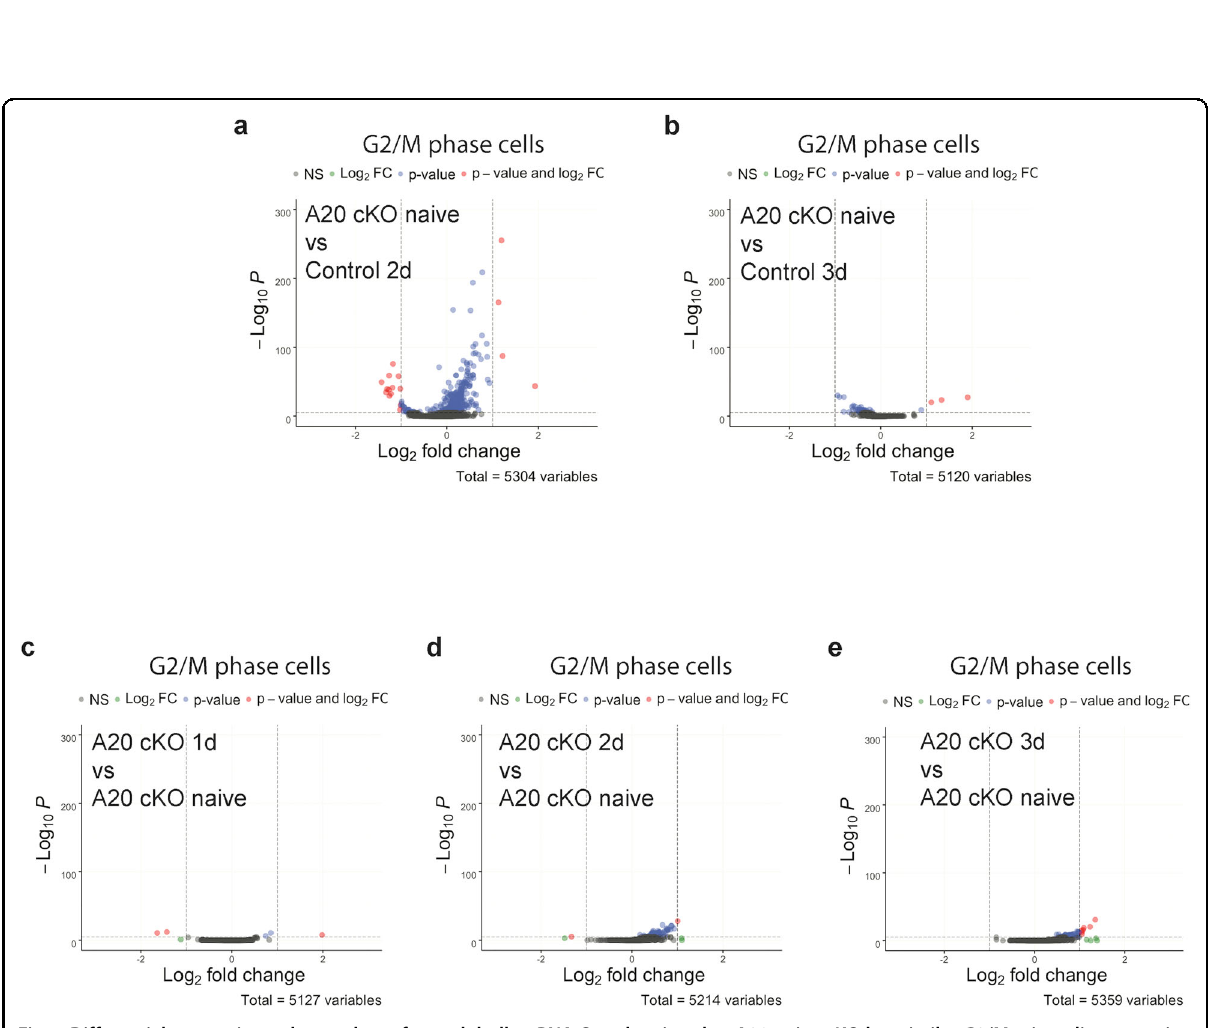
Fig. 4 Differential expression volcano plots of pseudobulk scRNA-Seq showing that A20 naive cKO has similar G2/M microglia expression pro fi le as control 3 days after nerve injury. a The G2/M-phase microglia of naive uninjured Cx3cr1-creER-yfp/ + ; Tnfaip3 fl / fl A20 cKO animals exhibited different gene expression pro fi le from the G2/M phase microglia of control Cx3cr1-creER-yfp/ + ; + / + animals 2 days after nerve injury. b The G2/M-phase microglia of naive uninjured Cx3cr1-creER-yfp/ + ; Tnfaip3 fl / fl A20 cKO animals shared similar gene expression pro fi le with the G2/M-phase microglia of control Cx3cr1-creER-yfp/ + ; + / + animals 3 days after nerve injury. c , e The gene expression pro fi le of the G2/M-phase microglia from Cx3cr1-creER-yfp/ + ; Tnfaip3 fl / fl A20 cKO animals remained largely unchanged 1 day ( c ), 2 days ( d ), or 3 days ( e ) after nerve